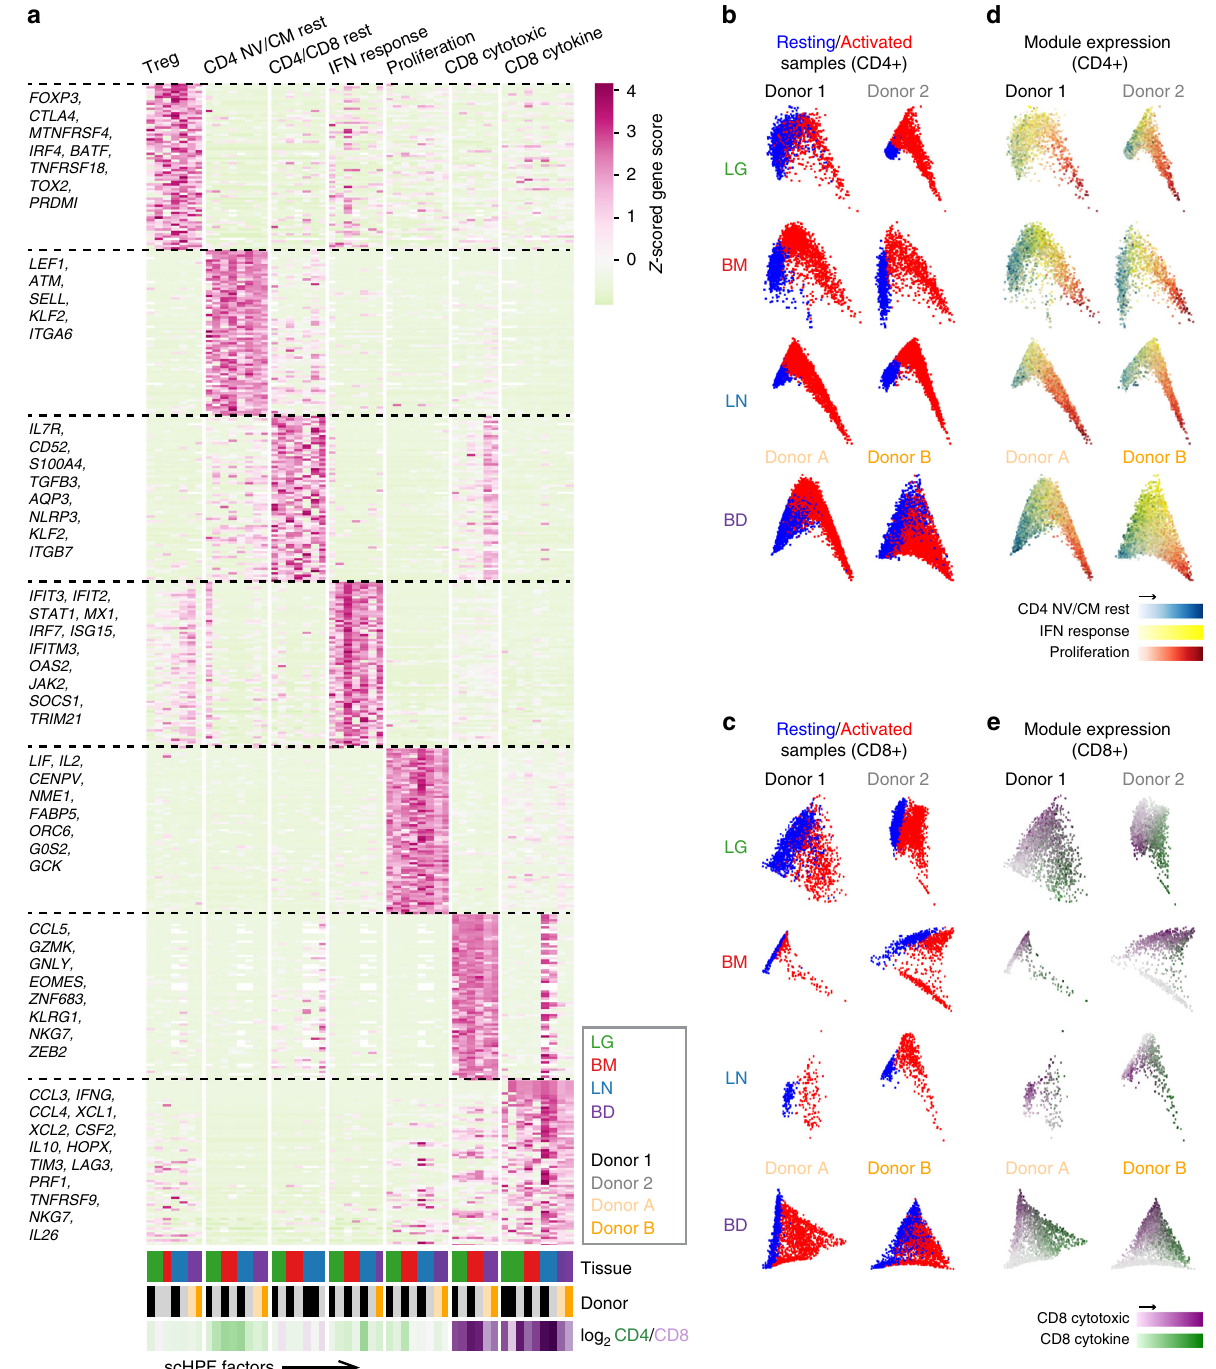
Fig. 4 De fi ning conserved transcriptional states in resting and activated T cells by single-cell Hierarchical Poisson Factorization (scHPF). a Heatmap shows gene scores for the top genes (rows) in each expression module identi fi ed by clustering scHPF factors (columns) that were computed in separate analyses of cells from each tissue and donor (Supplementary Fig. 8a). Selected genes are indicated to the left, and complete lists of top genes are available in Supplementary Data 5. Color bars at the bottom of the heatmap indicate each factors ’ tissue of origin, donor of origin, and CD4/CD8 bias. (NV/CM = naive or TCM). b Diffusion maps of CD4 + T cells in each tissue and donor, with cells colored by sample origin as resting (blue) or activated (red). c Same as ( b ) but for CD8 + T cells. d Diffusion maps of CD4 + T cells from ( b ), with cells colored by their average expression of the top genes from scHPF expression modules. Colors for different modules (CD4 NV/CM Resting, IFN Response, Proliferation) were blended using the RGB color model. e Diffusion maps of CD8 + T cells from ( c ), with cells colored by their average expression of the top genes from scHPF expression modules (CD8 Cytotoxic and CD8 Cytokine). Source data listing gene scores in ( a ) are provided in the Source Data fi